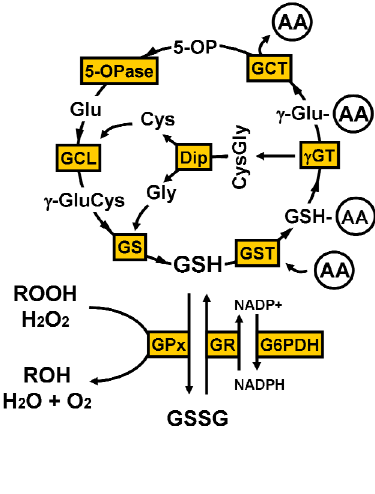
Figure 1. The γ -glutamyl cycle. AA, amino acids; Cys, cysteine; CysGly, cysteinylglycine; Dip, dipeptidase; GCL, γ -glutamylcysteine ligase; GCT, γ -glutamyl